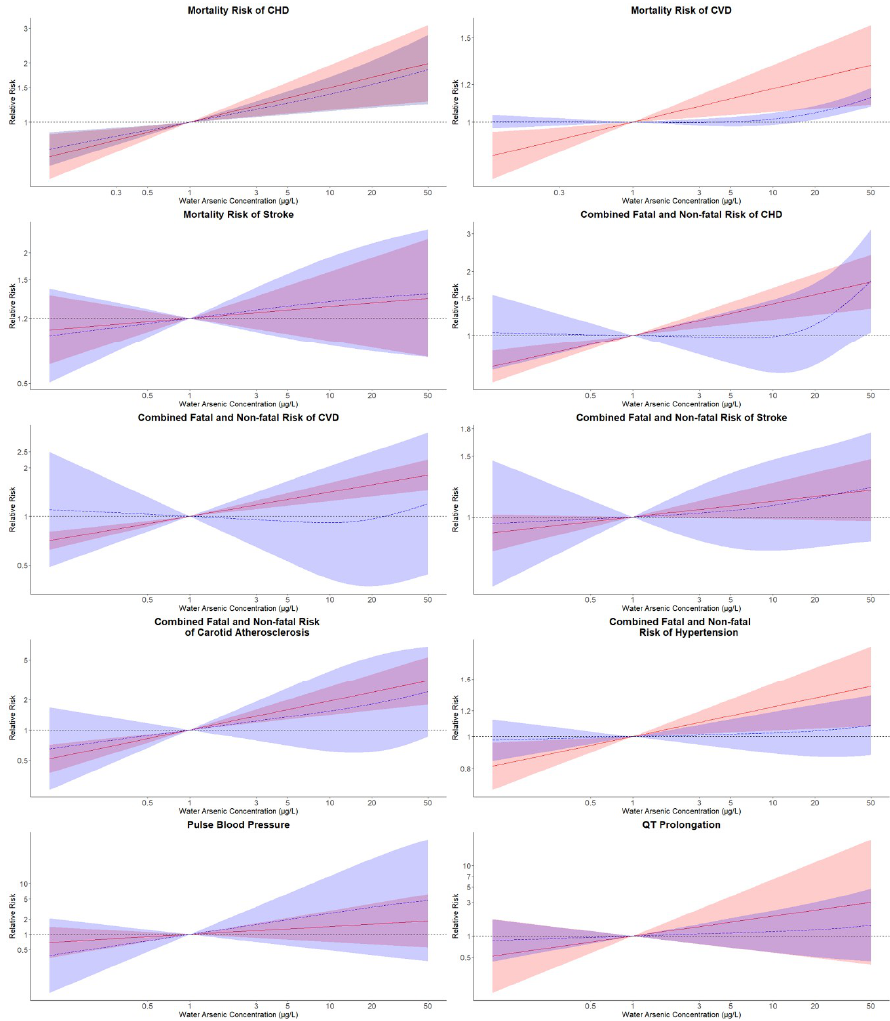
Figure 2. Pooled log-linear and non-linear relative risks and 95% confidence intervals (CIs) of different CVD endpoints in relation to the estimated drinking water arsenic concentration. Pooled log-linear and non-linear relative risks of CVD endpoints were estimated for drinking water arsenic concentrations with reference to an arsenic concentration of 1 µg/L. Solid lines (red) correspond to pooled relative risks of linear models with their 95% CIs represented as shaded regions (red). Pooled relative risks of non-linear models were represented by long-dash lines (blue) and their 95% CIs were plotted as shaded areas (blue). Log-linear models were estimated with log-transformed estimated drinking water arsenic concentration and non-linear associations were estimated from models with restricted cubic splines of log-transformed water arsenic concentration with knots at the 10 th , 50 th and 90 th percentiles of log-transformed water arsenic (CVD: cardiovascular disease; CHD: coronary heart disease).